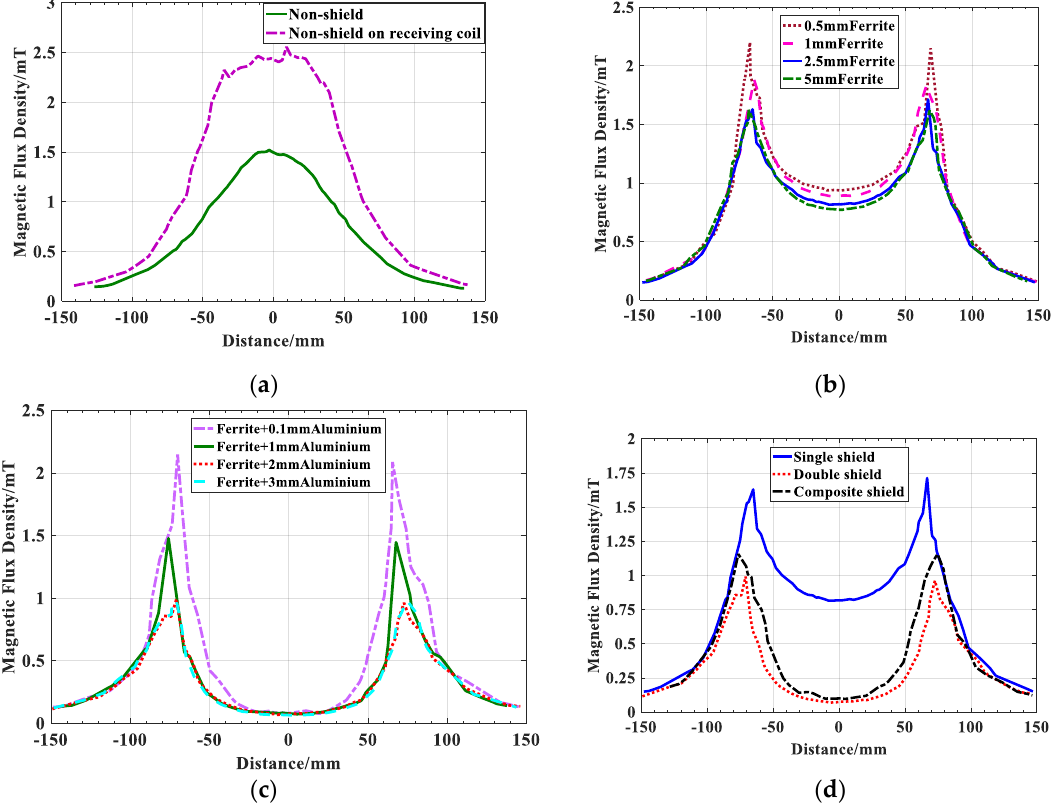
Figure 8. Magnetic flux density versus simulated measurement position at radial 10 mm above receiving coil. ( a ) No shielding. ( b ) Single shield magnetic coupler with different ferrite thickness. ( c ) Double shield magnetic coupler with different aluminum thickness. ( d ) Comparison of different shielding types.